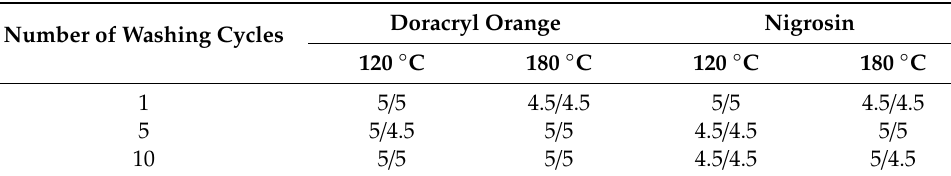
Table 2. Fastness to washing of amorphous m-aramid fabrics dyed in EMIM-EtSO 4 with Doracryl Orange and Nigrosin at 120 ◦ C and 180 ◦ C, respectively, after 1, 5 and 10 washing cycles (accompanying fabric cotton / polyamide).